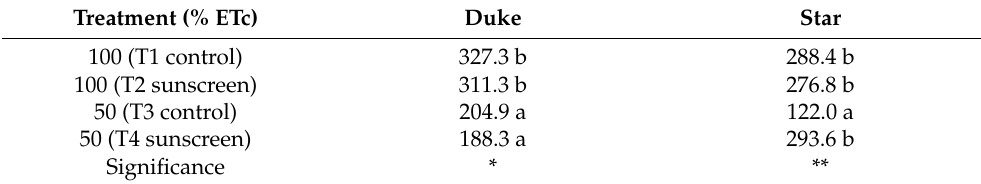
Table 5. Stomatal conductance (mol H 2 O m − 2 s − 1 ) measured on 12 December in the performed treatments on the Duke and Star